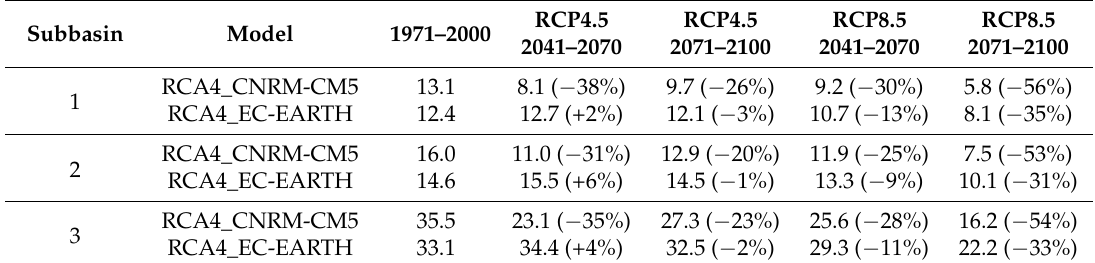
Table 8. Spatial streamflow means distribution (m 3 /s) and relative changes of